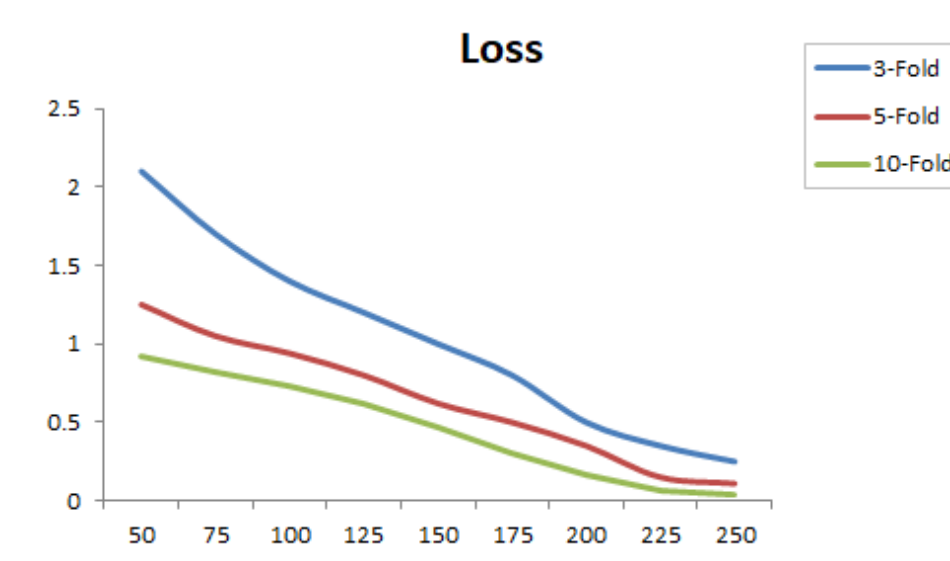
Figure 14. Training accuracy on 3 - fold, 5 - fold and 10 - fold cross validation.